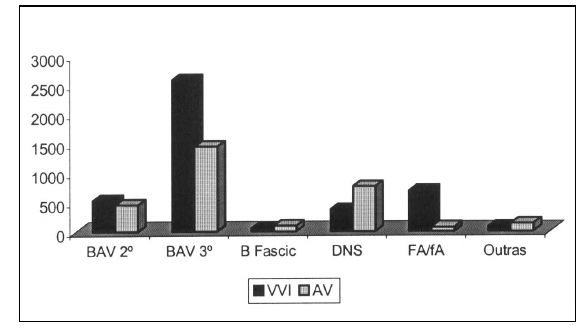
Fig. 9a - Modos de estimulação utilizados nos implantes iniciais, agrupados segundo o achado eletrocardiográfico dos pacientes.